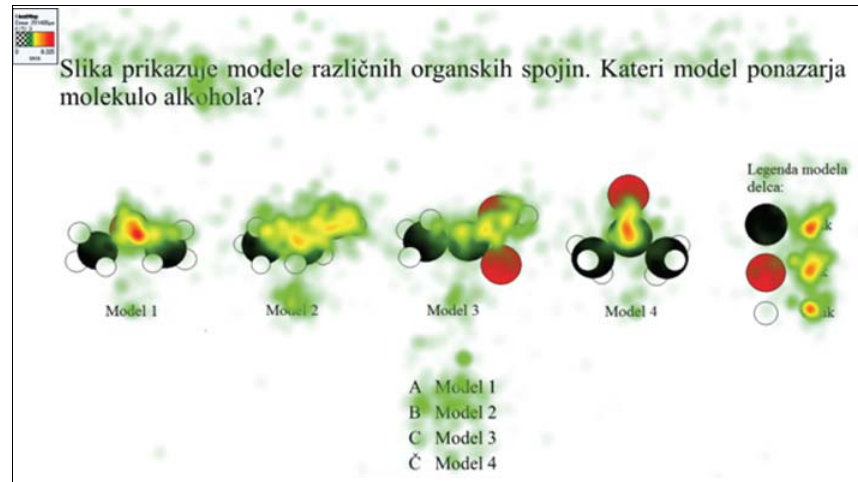
Figure 2. A heat map for Task 1 shows the relative density of fixations using a color